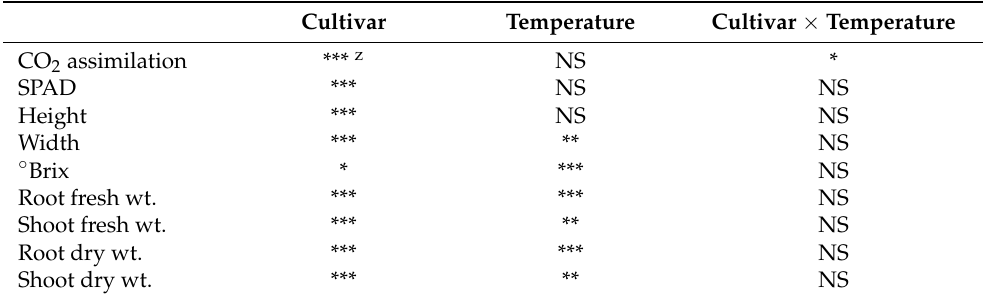
Table 1. Tests of effects for water temperature (18.3 ◦ C, 21.1 ◦ C, and ambient) and seventeen lettuce cultivars grown in NFT hydroponics systems at OSU research greenhouses in Stillwater, OK, USA.